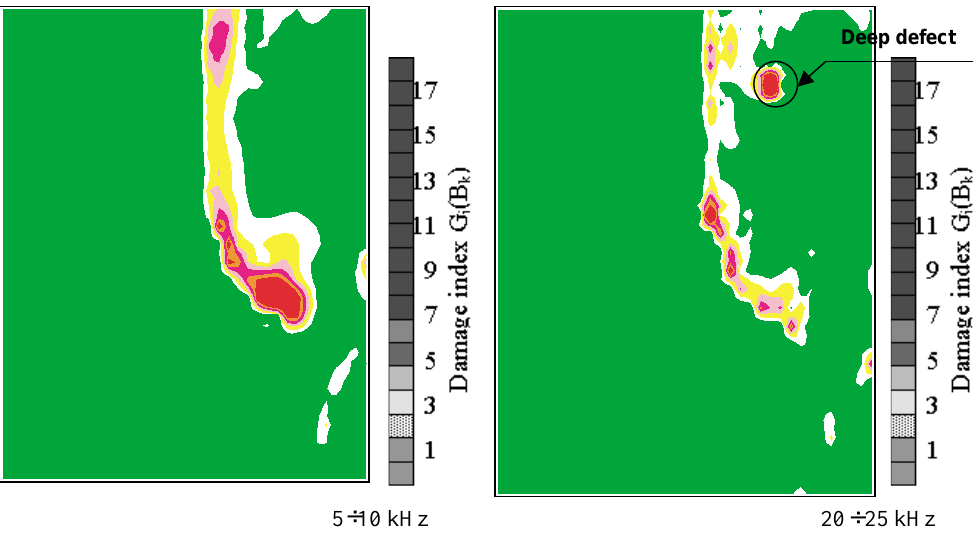
Fig. 19. Damage Index maps for the Byzantine icon at different frequency